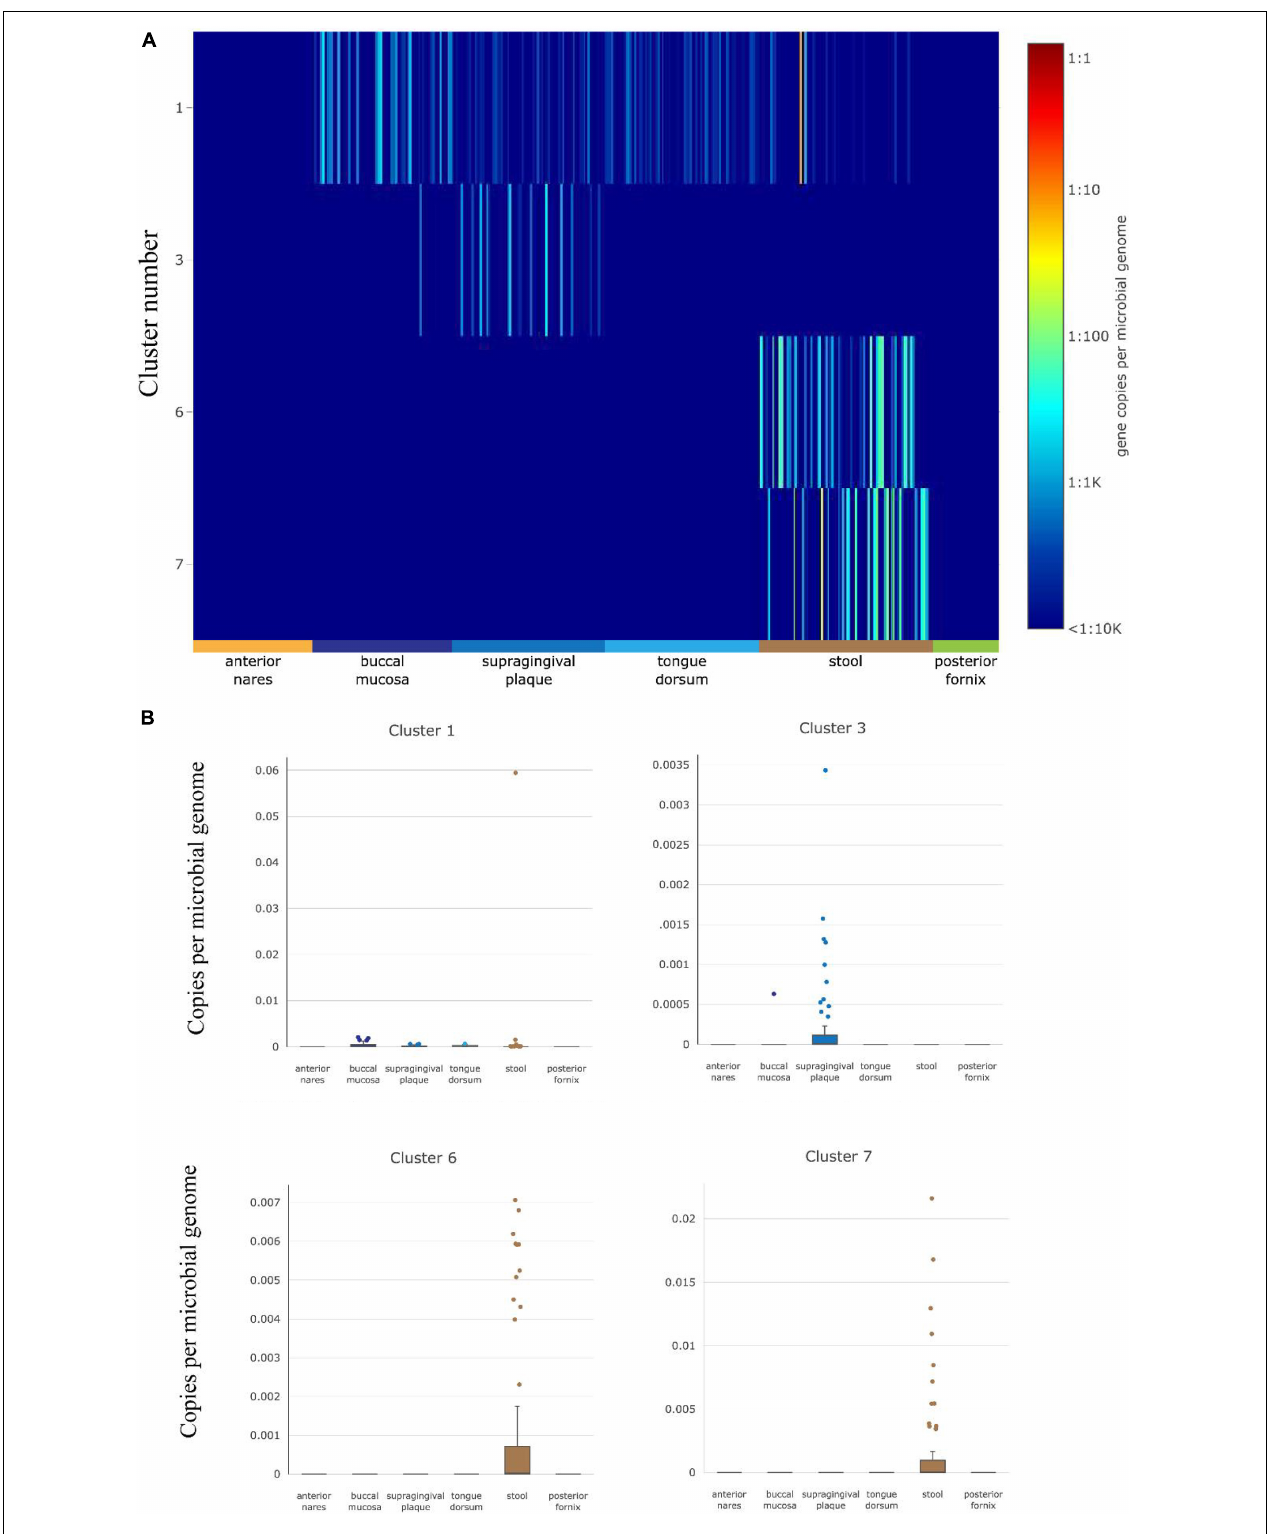
FIGURE 2 | HepI abundance in the human microbiome datasets of healthy subjects. (A) Heatmap of the distribution and abundance of HepI clusters analyzed by ShortBRED, which include vaginal fornix, stool and facial parts such as the buccal mucosa, anterior nares, tongue dorsum. (B) Boxplots of clusters 1, 6, and 7 across different body